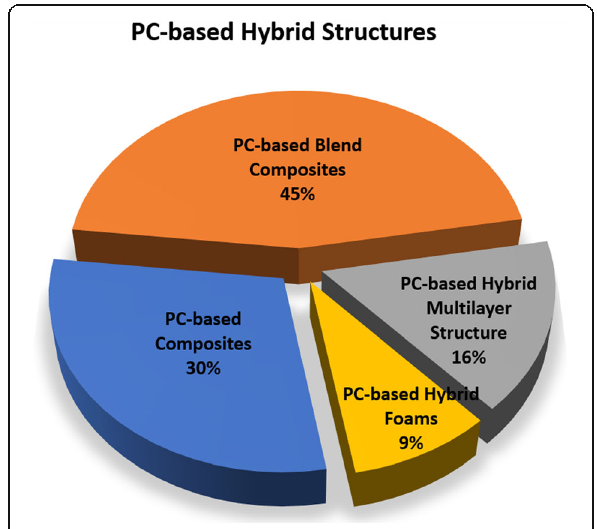
Fig. 22 Percentage of published research papers in different categories of PC-based hybrid structures since